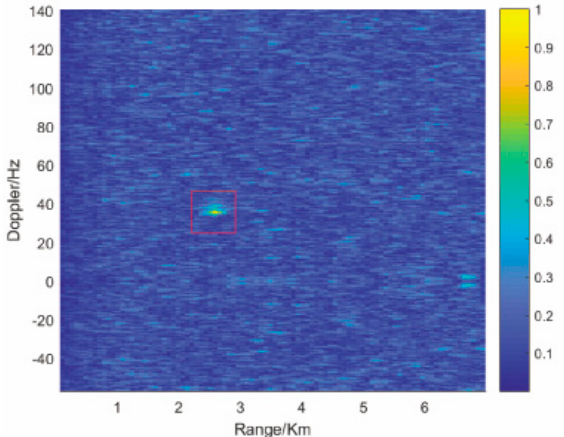
Figure 13. RD map based on MFRT.